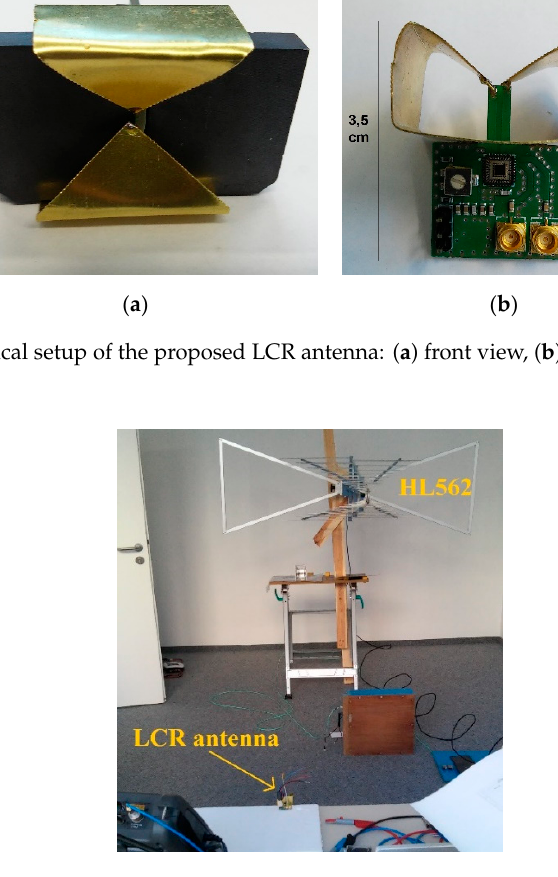
Figure 22. Transmission coefficient of the proposed LCR antenna measured under multiple different conditions: yellow—with larger absorbers, blue—without absorber, red—100 mA output stage current, green—200 mA output stage current. Professional antenna DRH20 measured for comparison (purple).